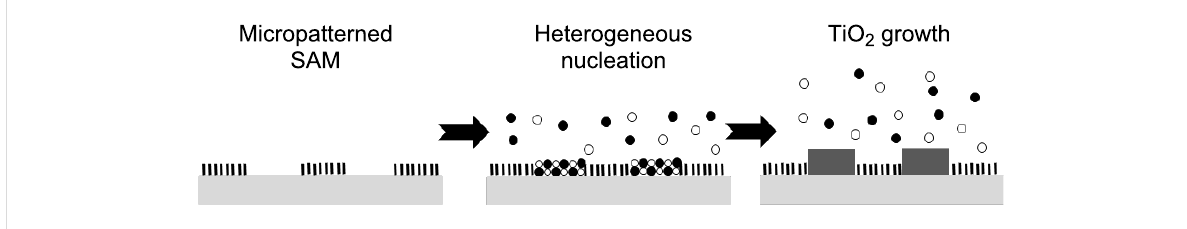
Figure 4: Patterning of SAM on a substrate followed by selective growth directly on the substrate.